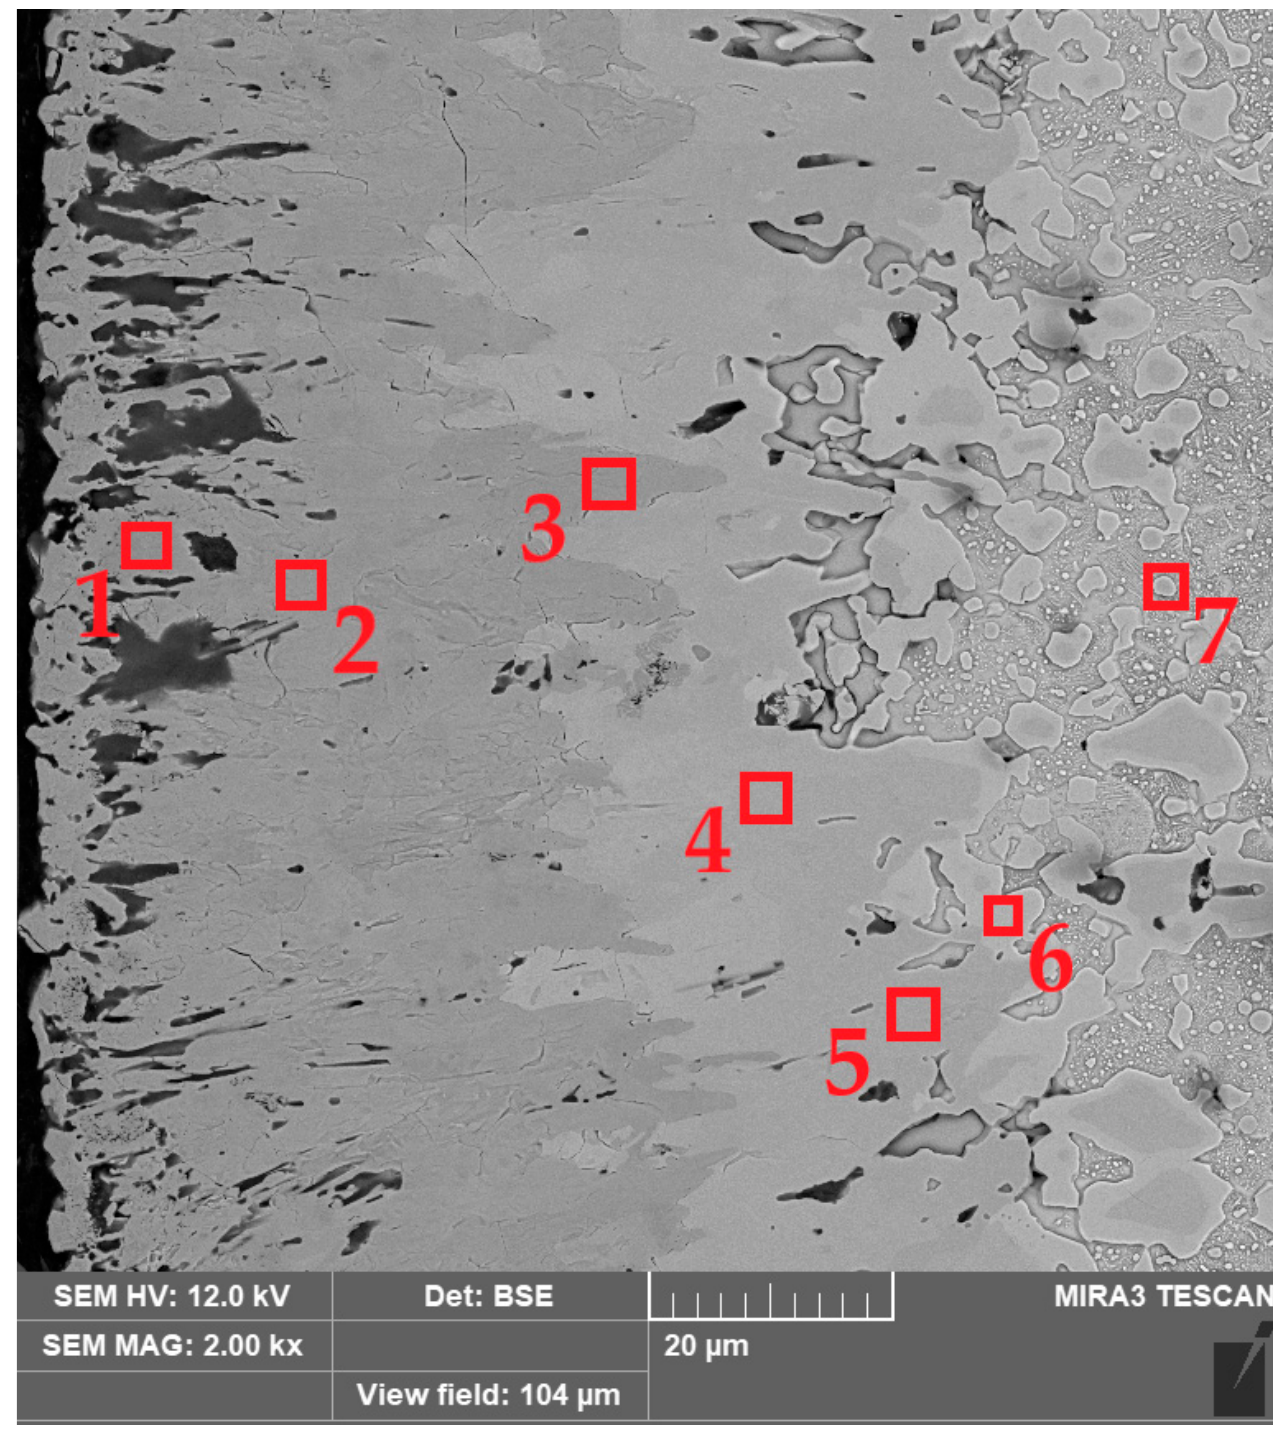
Figure 9. BSE image of microstructure of X165CrV12 tool steel after powder-pack boriding at the temperature of 1173 K for 9 h with marked areas examined by EDS microanalysis.